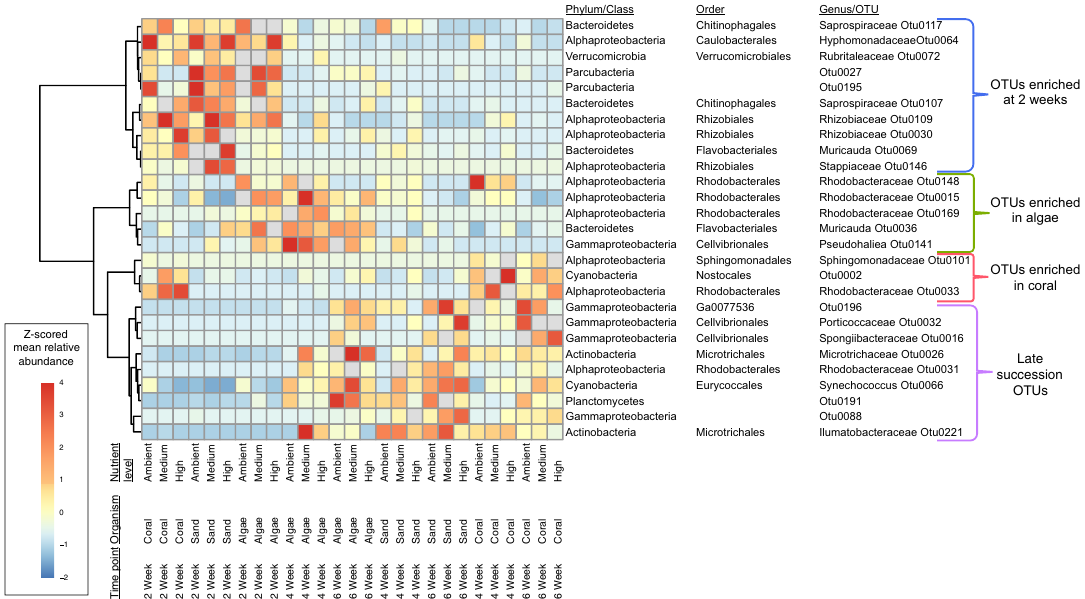
Fig. 5 Visualization of enrichment of bio fi lm OTUs associated with treatments and time points. Hierarchical clustering (Ward ’ s minimum variance method) organized statistically selected OTUs according to distributions of standardized (z-scored) mean relative abundance across treatments. OTUs that were both signi fi cant by linear mixed model and discriminant by random forest are displayed along the y -axis. Note the stronger similarity between selected OTU enrichment patterns at earlier stages of development compared with later time points. Later time points separate primarily according to benthic organism, and further cluster by time point within these